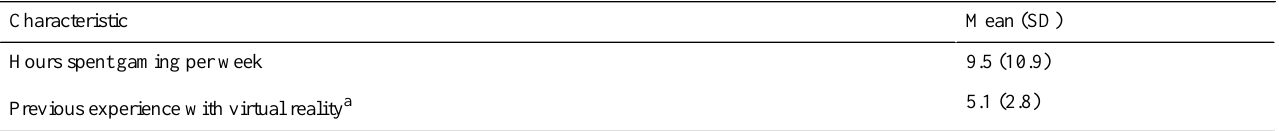
Table 1. Descriptive characteristics of the sample’s gaming habits and previous experience with virtual